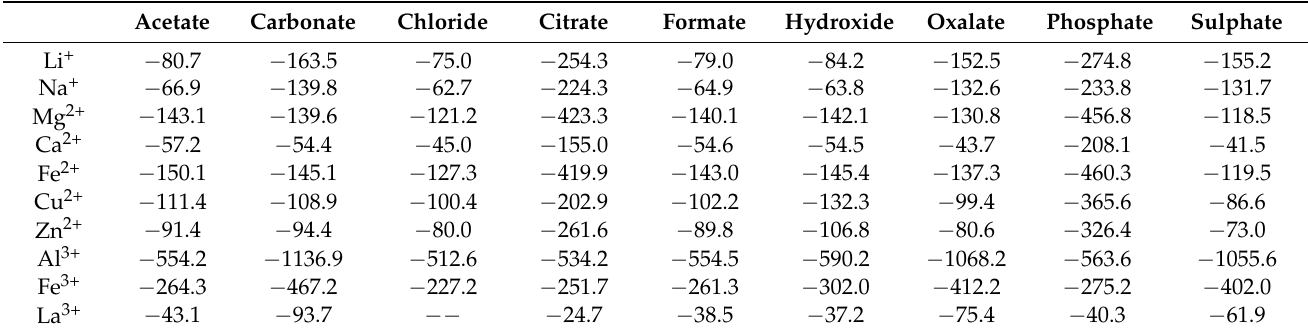
Table 1. Formation energies for all complexes considered in the present study in kcal/mol. For lanthanum chloride, no stable complex was found. Acetate Carbonate Chloride Citrate Formate Hydroxide Oxalate Phosphate Sulphate